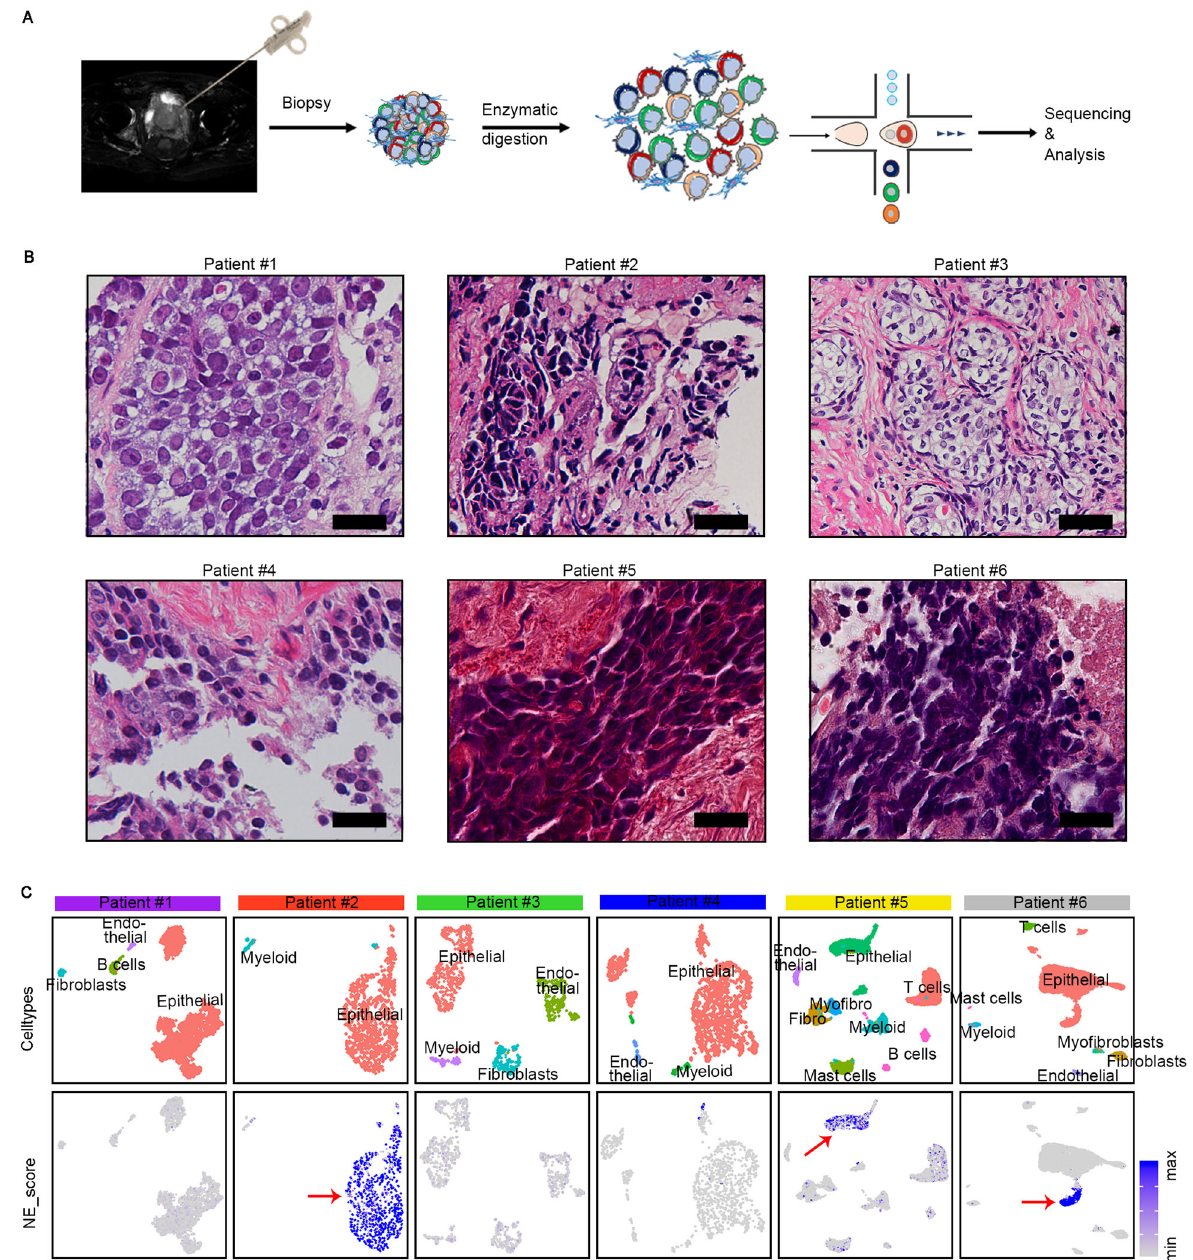
Fig. 1 Single-cell transcriptomic pro fi ling of 6 CRPC tumors. A Work fl ow for single-cell extraction, sequencing, and analysis. B Haematoxylin and eosin (H&E) staining for 6 CRPC patients. The scale bars represent 25 μ m. C UMAP plots of cells from six patients with cells colored based on the cell types (upper row) and NE scores using the well-established NE marker genes (lower row). The minimum score is indicated by light gray and the maximum score is indicated by blue. The red arrows pointed to high NE score cell